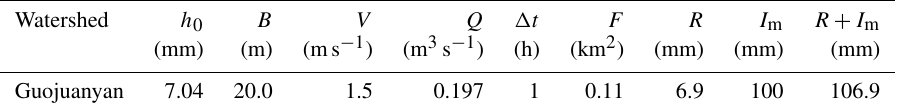
Table 5. The calculated process of the rainfall threshold.